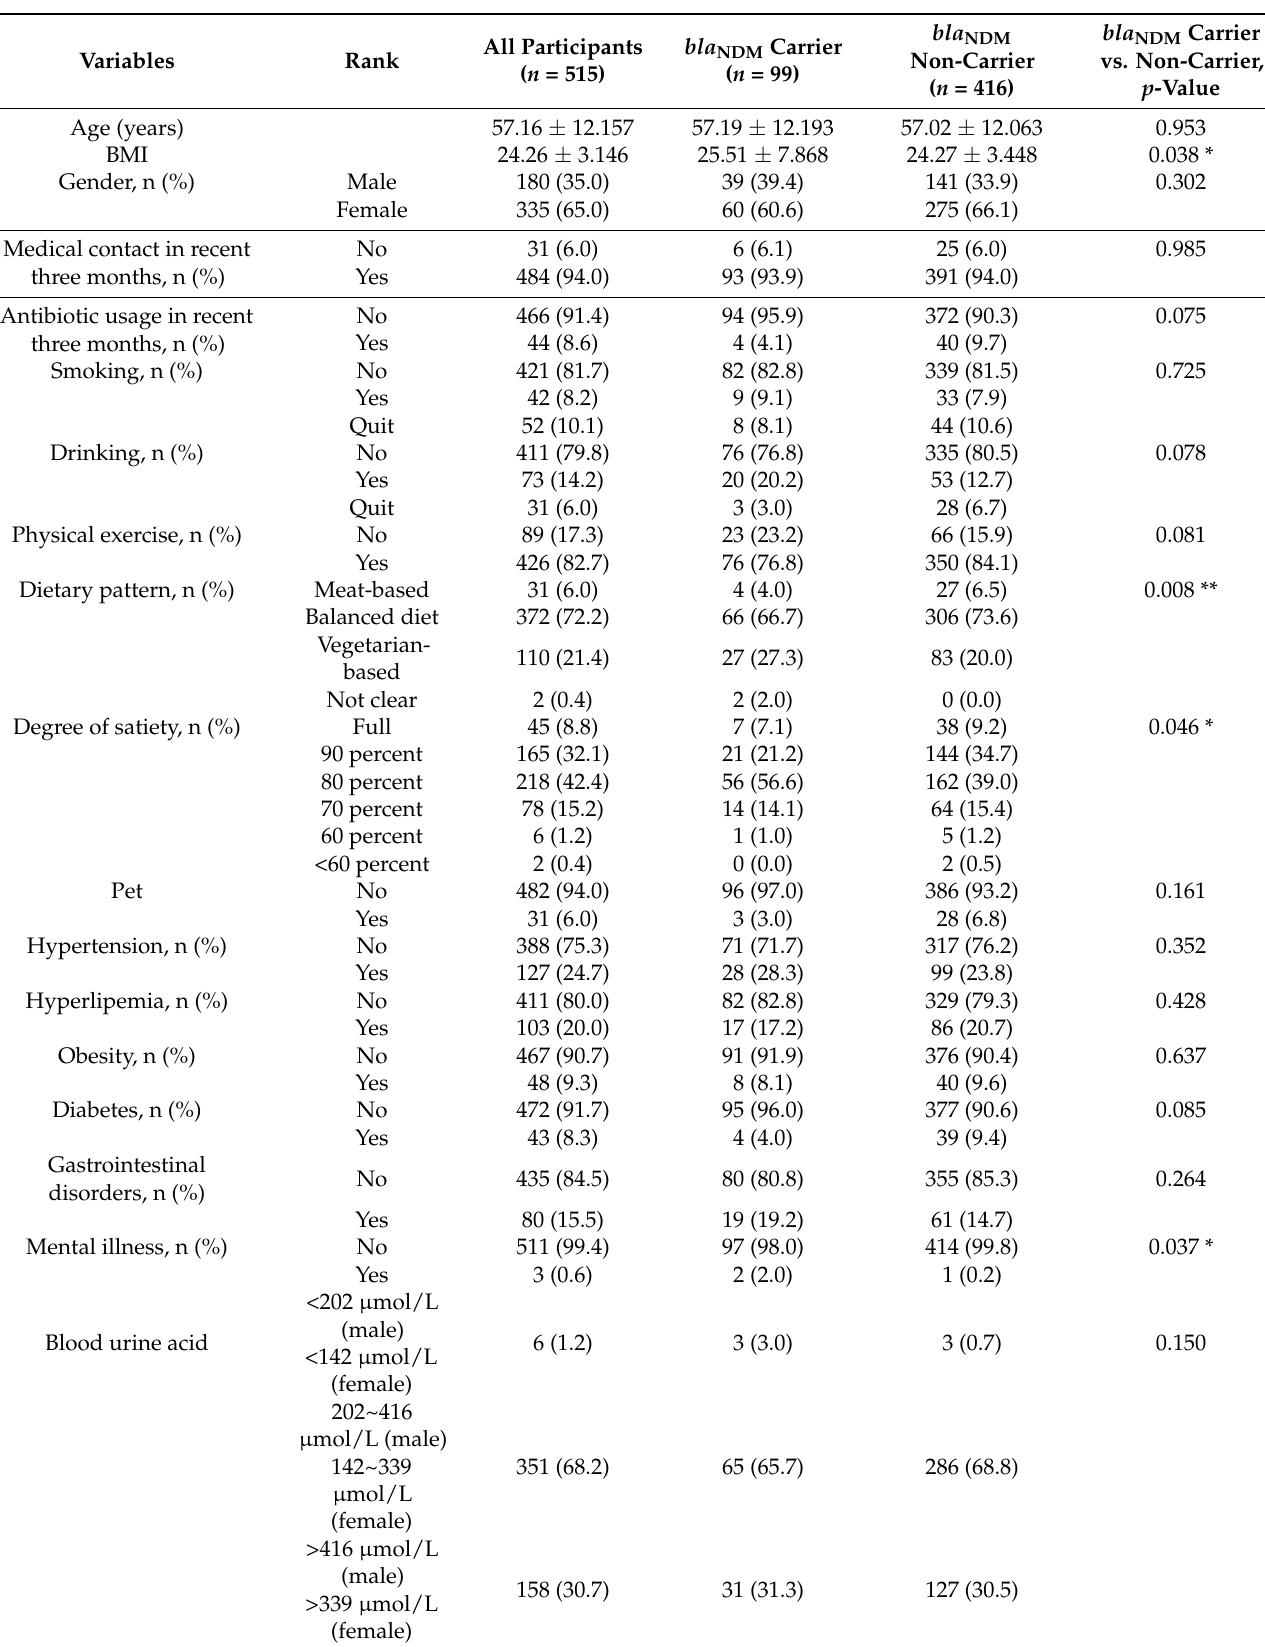
Table 1. Baseline demographics of the participants with or without fecal carriage of bla NDM